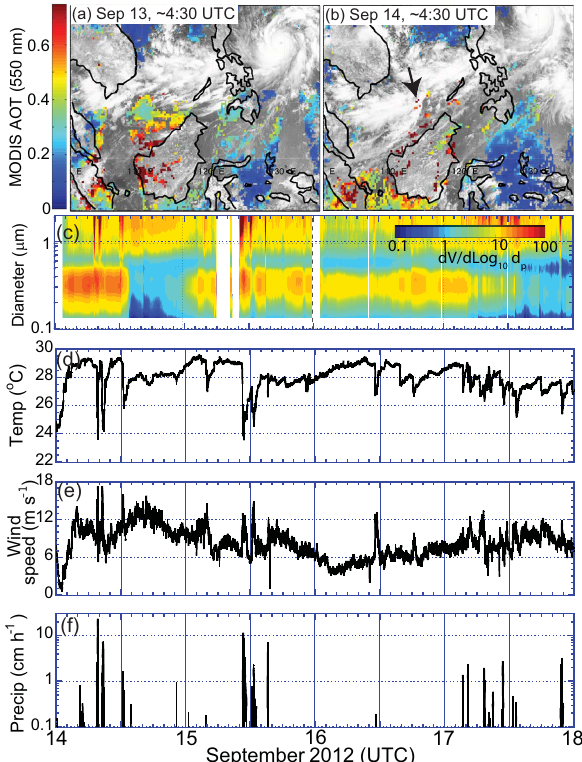
Figure 7. Satellite data and Vasco 1min time series data describing the 14–17 September transport event. (a, b) Combined Terra and Aqua MODIS C6 550nm AOT overlaid on MTSAT visible channel for 13 and 14 September, respectively; (c) PCASP volume distri- bution; (d) temperature; (e) wind speed; (f) precipitation rate. The presence of a large squall line originating from a massive thunder- storm over the Malaya Peninsula that resulted in the 14 September 12:00UTC clean period as evident in (c) is marked with an arrow in (b)